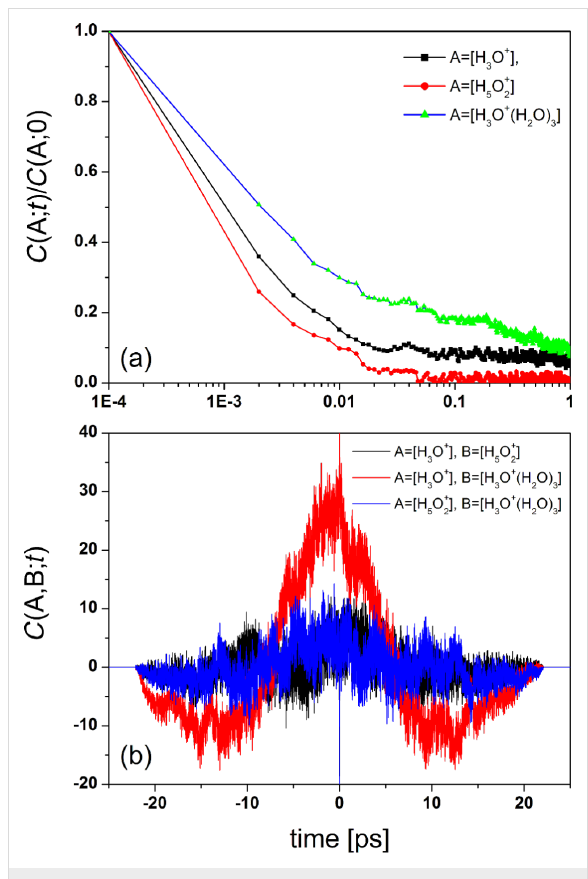
Figure 15: (a) Normalized time autocorrelation functions for the processes [A]( t ), where A denotes H 3 O + , H 5 O 2+ , and H 3 O + ·(H 2 O) 3 , at λ = 10. (b) Time-dependent cross-correlation functions (in arbitrary units) characterizing the formation of different pairs of hydrated proton complexes at λ =